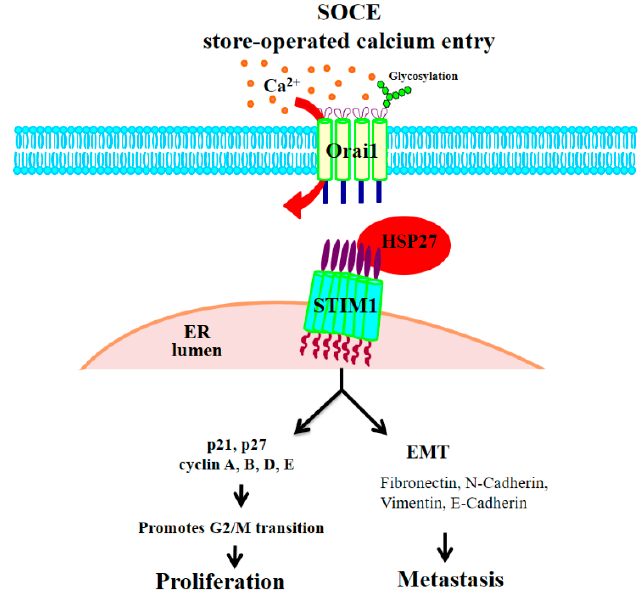
Figure 11. The proposed model for the role of HSP27 in CRC progression. HSP27 may interact with STIM1 to maintain the stability of STIM1. Silencing HSP27 caused a reduction of STIM1 to regulate the growth activity and metastasis ability on